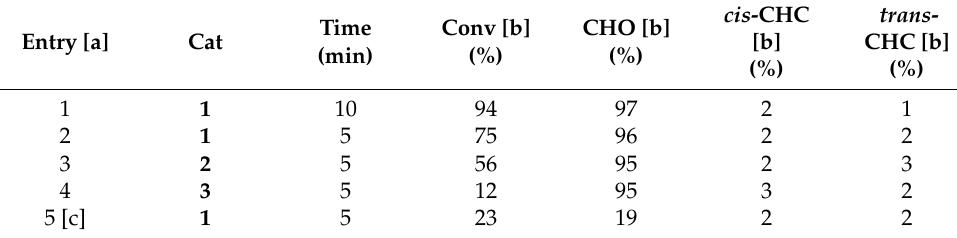
Table 4. Depolymerization of poly (cyclohexene carbonate), PCHC, using chromium complexes 1 – 3 .